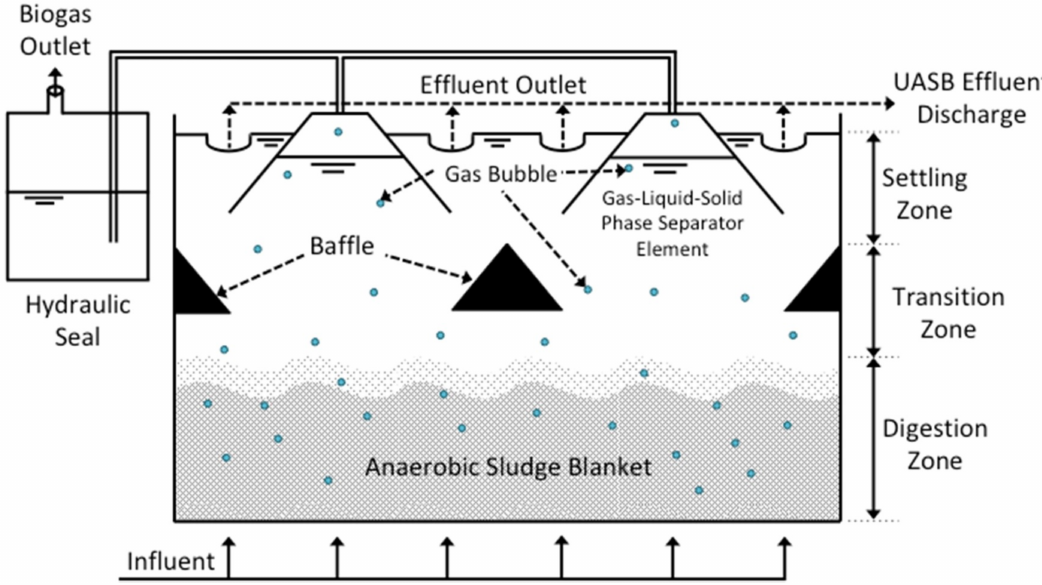
Figure 2. Schematic showing different components and zones of a UASBR system. (Figure